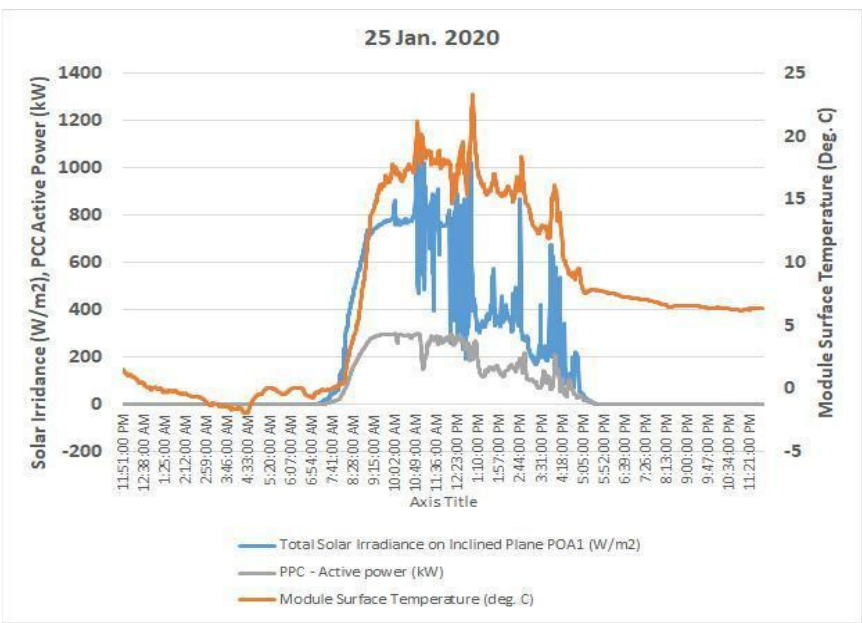
Figure 17. Variation of active power with temperature and irradiance on the day with the lowest module temperature. Table 4. Comparison of the performance ratio corresponding to different module surface tempera ‐ tures over two years.